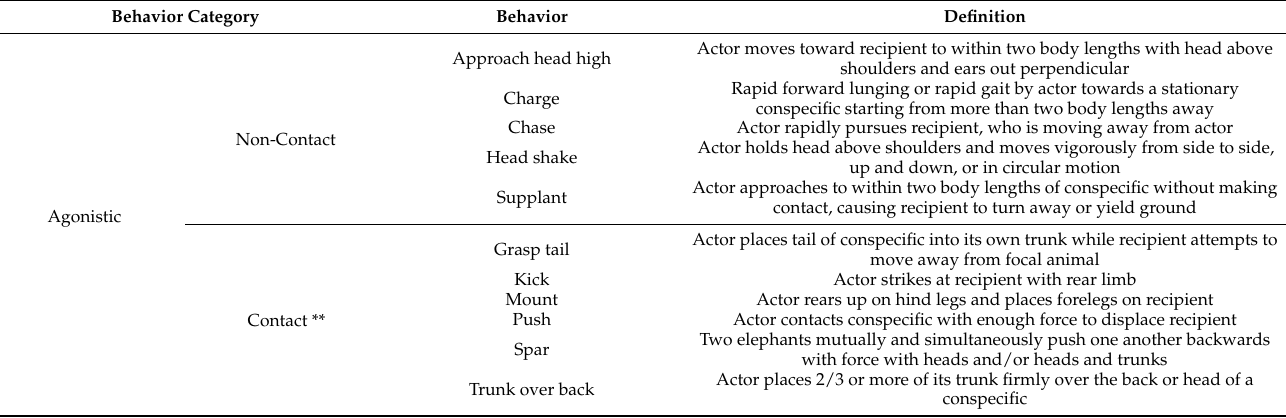
Table 1. Ethogram of behaviors for bachelor group of five bull Asian elephants at Denver